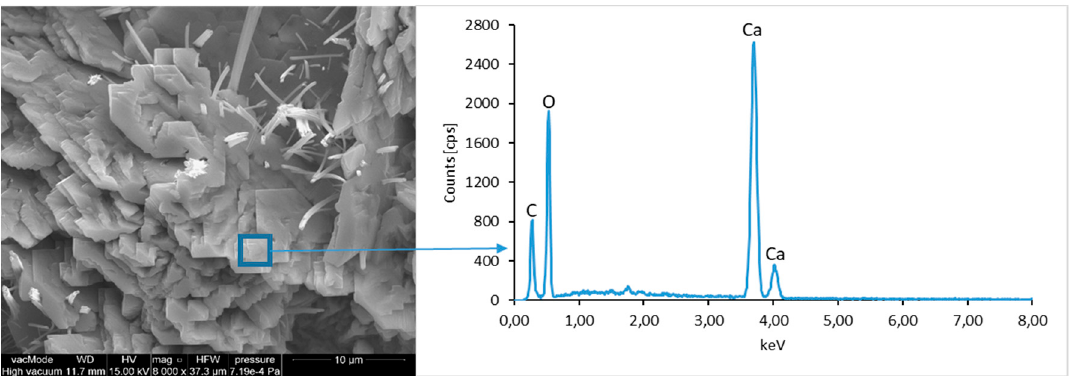
Figure 12. SEM micro-structure of CII.0 concrete and results of elemental analysis in EDS micro-area (portlandite)—well-formed portlandite crystals with C–S–H phase fibers are visible.